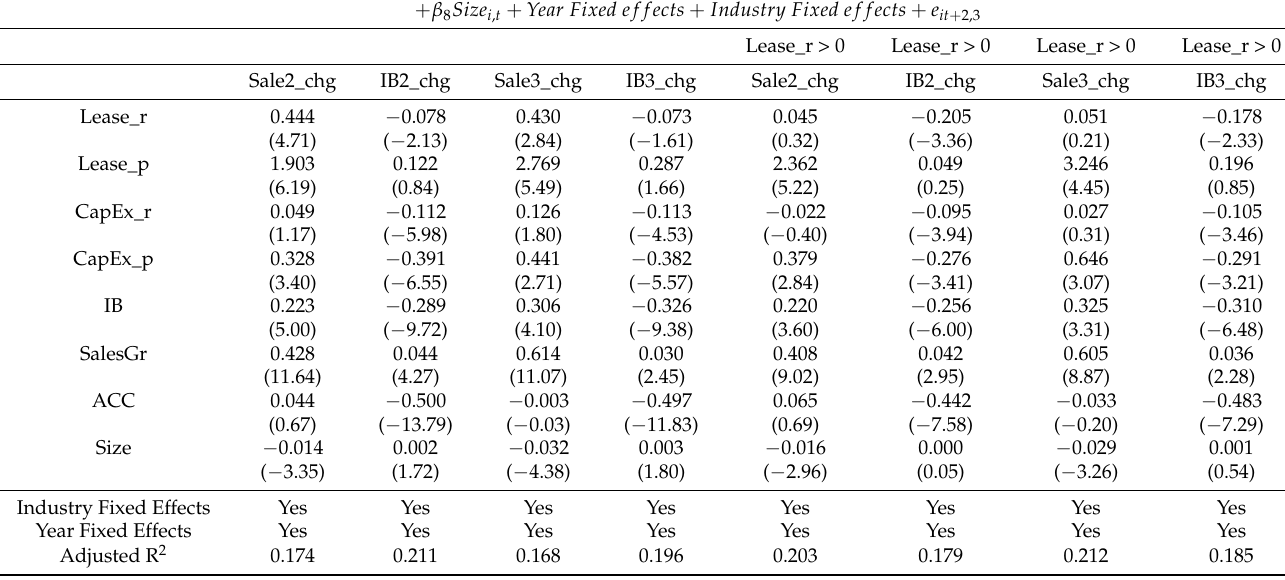
Table 7. Association between Investments in Leases and Two-Year-Ahead and Three-Year-Ahead Performance. 2 or 3 − year Future Performance i , t +